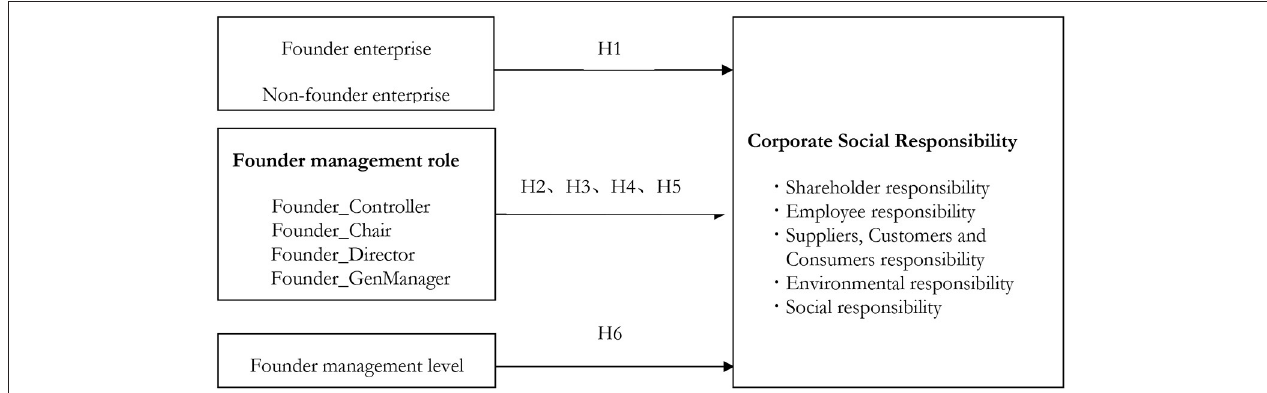
FIGURE 1 | Conceptual Model of founder and corporate social